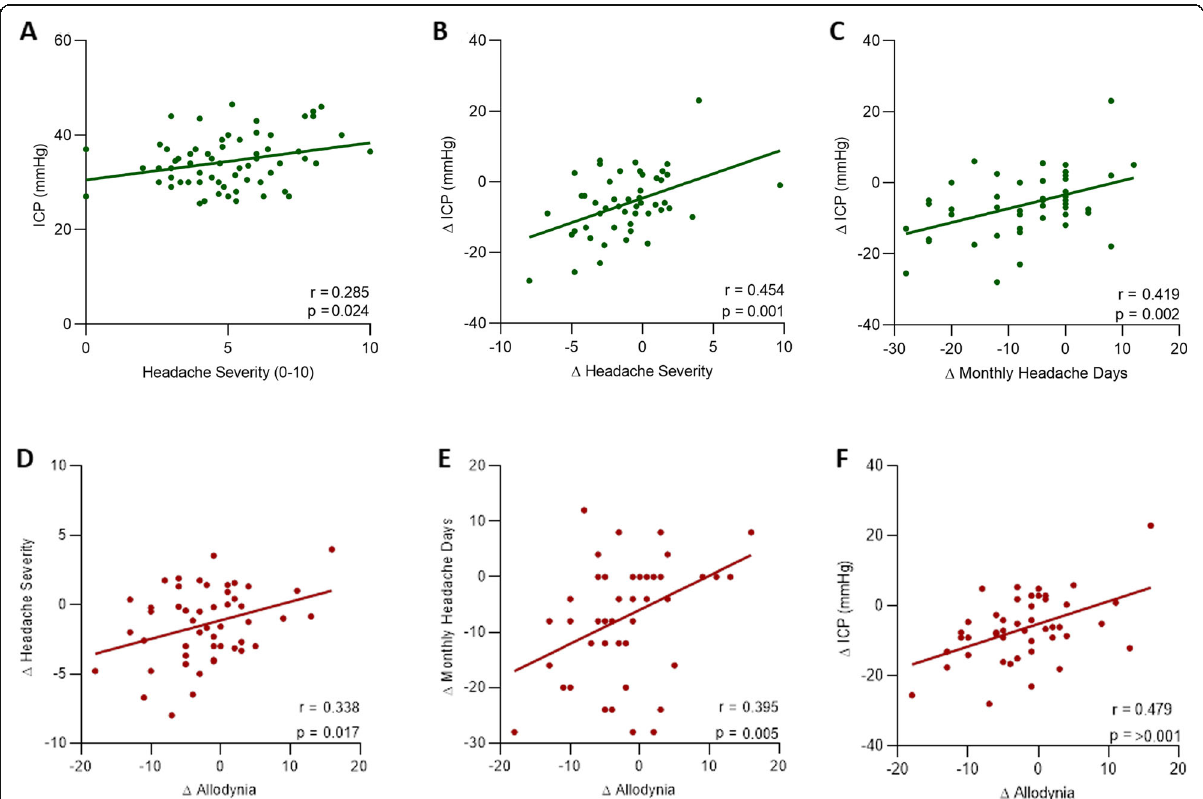
Fig. 1 Relationship between ICP and headache. Correlation of baseline headache severity (HS) against baseline intracranial pressure (ICP) ( A ); ICP correlated with change in HS ( B ) change in monthly headache days (MHD) ( C ) Change in MHD correlated with ICP between baseline and 12 months. Correlation of the change allodynia scores between baseline and 12 months against change in HS ( D ); change in MHD ( E ); ICP ( F ) between baseline and 12